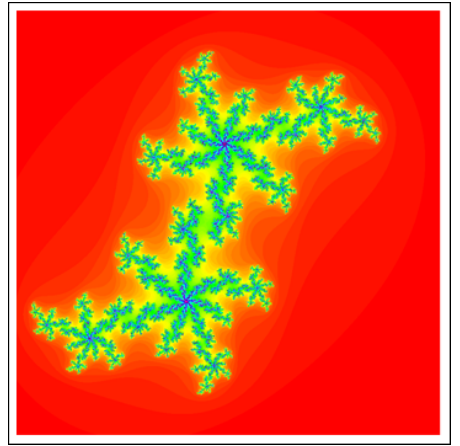
Figure 7. J-set via F-iteration with image visual period = 57 s.